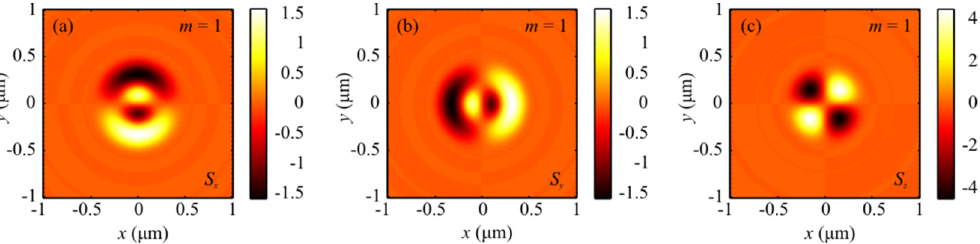
Figure 5. Distribution of SAM vector components S x ( a ), S y ( b ), and S z ( c ) when focusing a plane wave with the hybrid polarization of Equation (1) at m = 1.